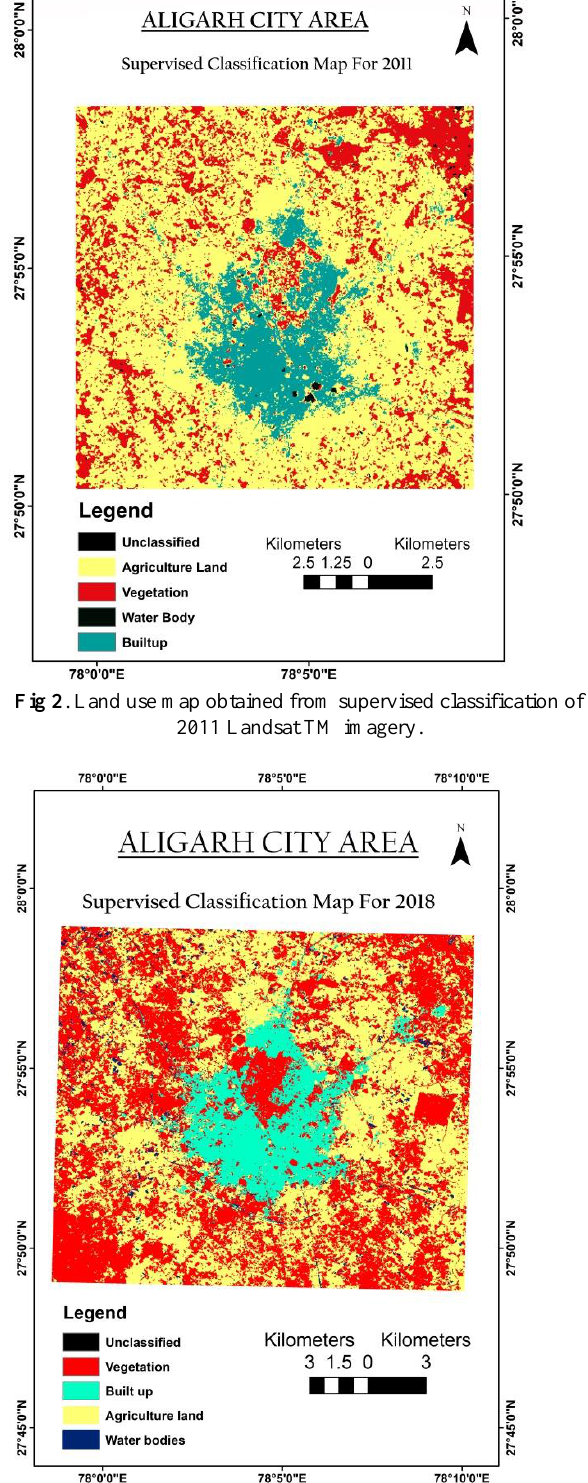
Fig 3 . Land use map obtained from supervised classification of 2018 Landsat TM imagery.